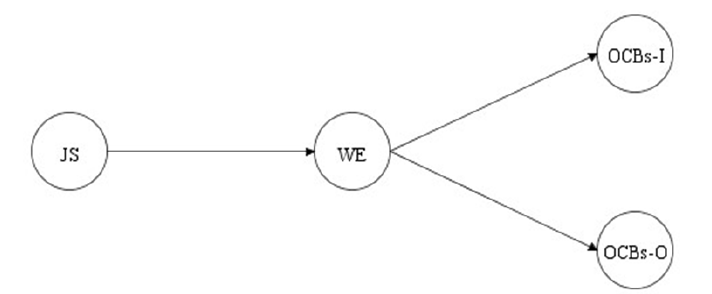
Figure 1. The hypothesized mediational model. Note: JS = job satisfaction; WE = work engagement; OCBs-I = organizational citizenship behaviors directed toward individuals; OCBs-O = organizational citizenship behaviors directed toward the